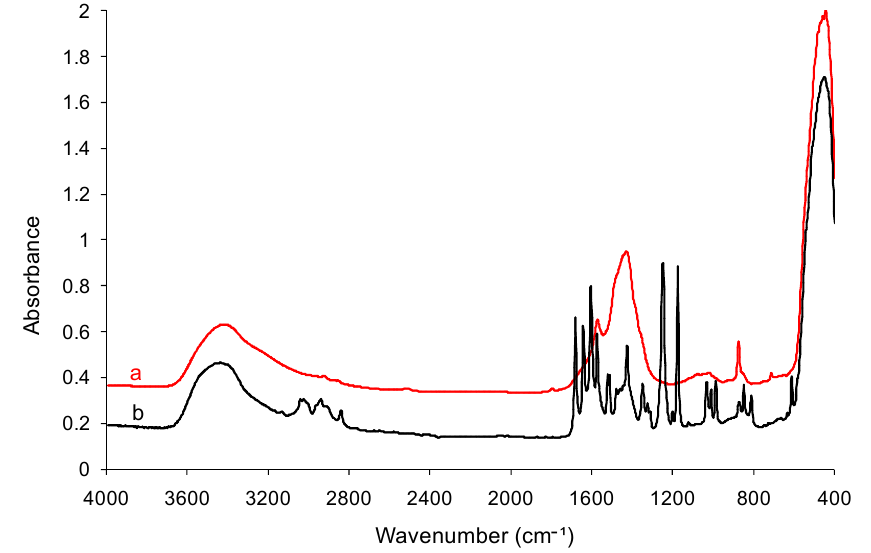
Figure 6. FTIR spectra of ZnO NPs obtained without PyQAs2 ( a ) and with 5% PyQAs2 ( b ). Table 3. Absorption bands from the FTIR spectra of ZnO NPs and correlations with vibrations of functional groups [37,38]. Absorption Bands (cm − 1 ) Vibrations Correlated with Absorption Bands Unmodified ZnO